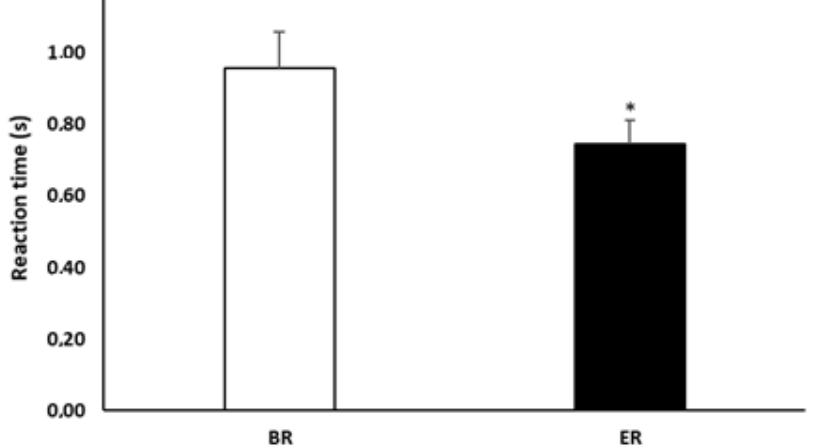
Figure 3. Reaction time recorded before Ramadan (BR) and at the end of Ramadan (ER). *: Significant difference compared to BR.